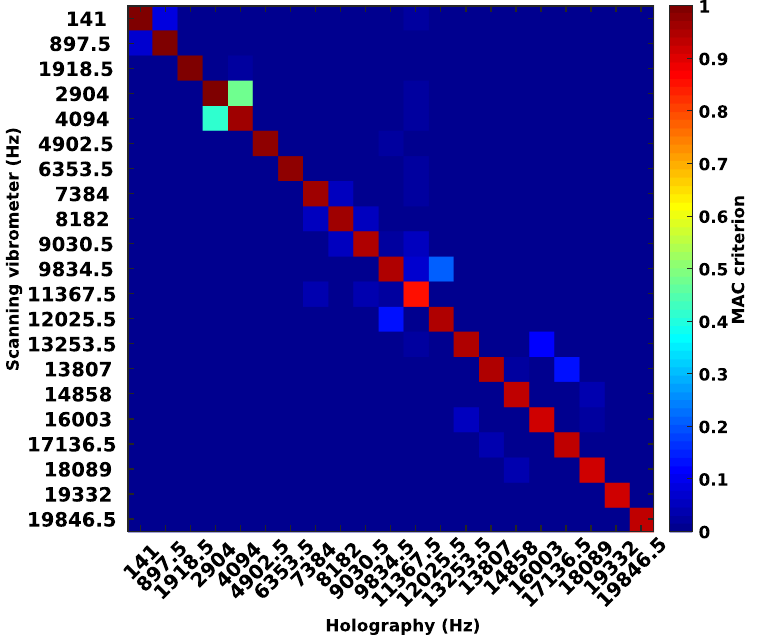
Figure 2. MAC criterion between scanning point-wise vibrometer and coherent imaging measurements for the set of 21 excitation frequencies from 141 to 19,846.5